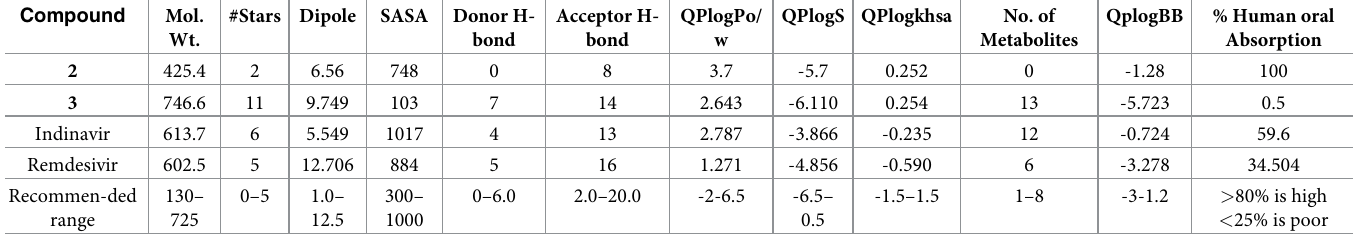
binding energy of − 71.63 and -81.92 kcal/mol, repectively, were used for molecular dynamics study with OPLS3e force field. The root mean square deviation (RMSD) plot in Fig 6A indicates that the compound 2 - SARS-CoV-2 main protease (PDB ID 6LU7) complex stabilized shortly after commencing the simulation i . e ., 2.5 ns, with respect to the reference frame at time 0 ns. The plot showed the Table 2. In silico predicted ADME properties of compounds 2, and 3.